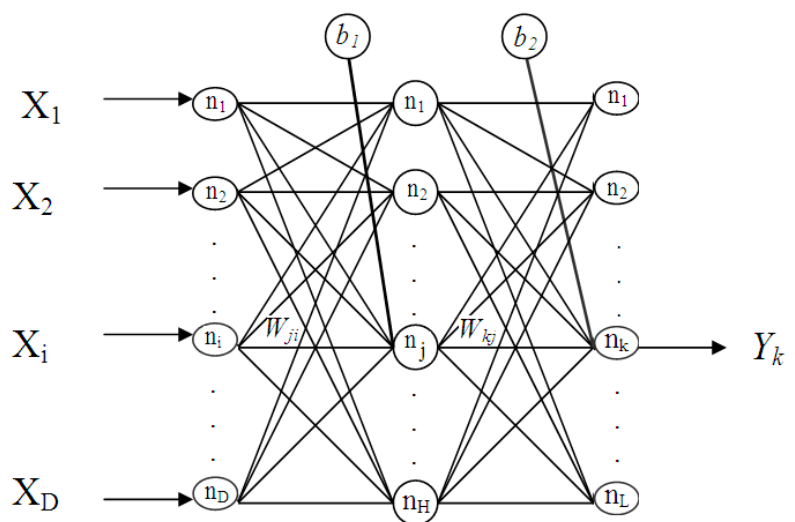
Figure 1. Typical structure of the ANN.